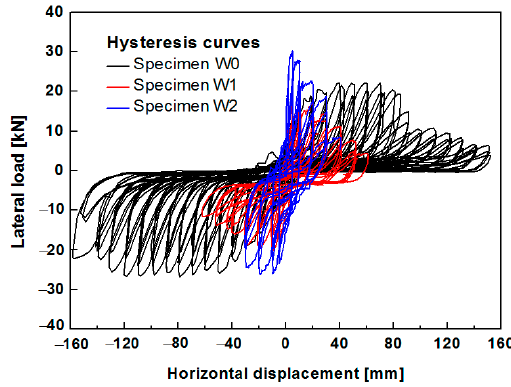
Figure 21. Hysteresis curves of specimens W0, W1, and W2. The hysteresis envelope curves of the three specimens are presented in Figure 22.